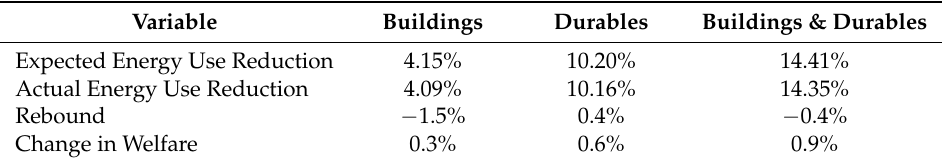
Table 1. Turkey Model Estimation, no Informal Sector or Energy Theft.